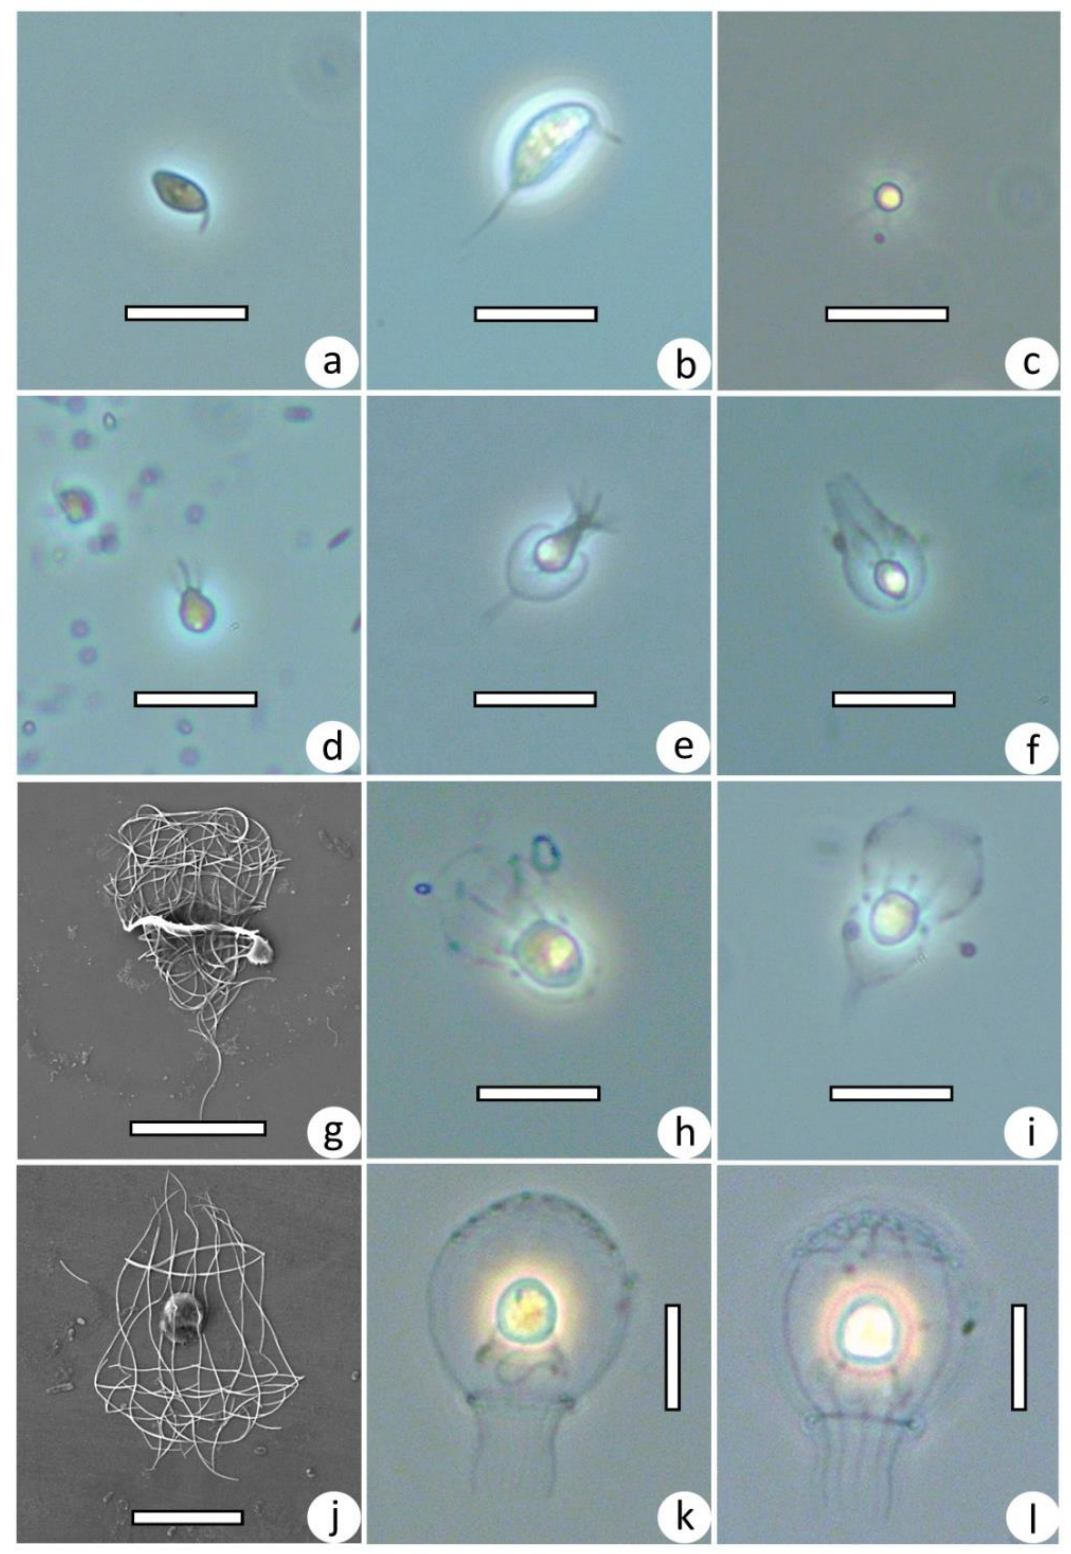
Figure 2. Morphology of the Obazoa flagellates observed (LM—( a – f , h , i , k , l ); SEM—( g , j )): ( a ) Amastigomonas caudata ; ( b ) Amastigomonas cf. mutabilis ; ( c ) Ministeria sp.; ( d ) Monosiga ovata ; ( e ) Salp- ingoeca sp.; ( f ) Savillea parva ; ( g , h ) Stephanoeca sp. 1 (( g )—lorica; ( h )—alive cell); ( i ) Stephanoeca sp. 2; ( j – l ) Diaphanoeca grandis (( j )—lorica; ( k , l )—alive cell). Scale bars: 10 µm.